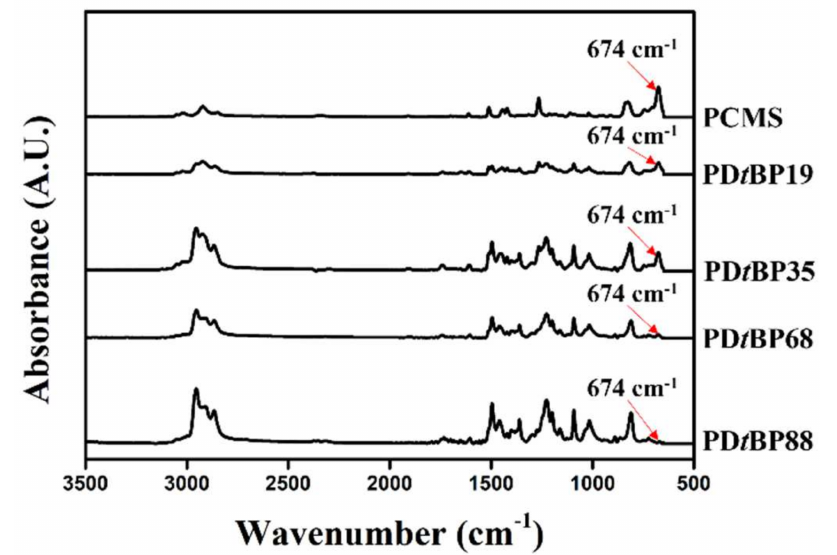
Figure 3. Fourier transform-infrared spectroscopy (FT-IR) spectra of PCMS and PD t BP#s.